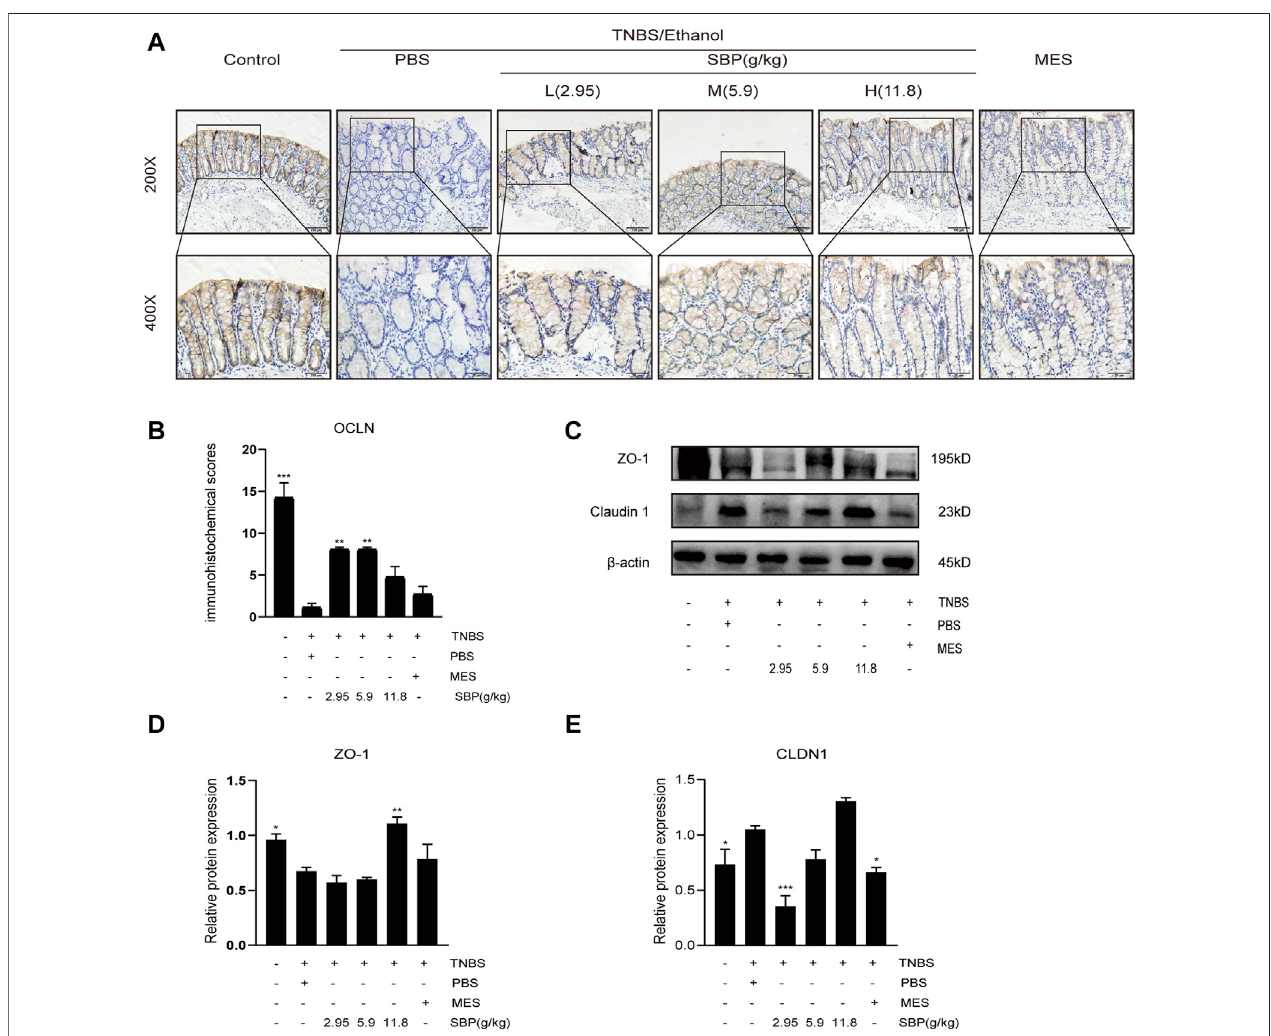
FIGURE 6 | SBP restored the epithelial tight junction in TNBS-induced colitis . (A,B) Representative immunohistochemistry images of colon tissues stained with OCLN. Scale bar = 100 µM (×200); Scale bar = 50 µM (×400). Quanti fi cation with Fiji ImageJ. (C – E) Primary components of tightjunction protein expression ofCLDN-1 and ZO-1 in different groups. vs. TNBS + PBS group, n = 3 rats/group, Data shown as means ± SEM. * p < 0.05, ** p < 0.01, *** p < 0.001.